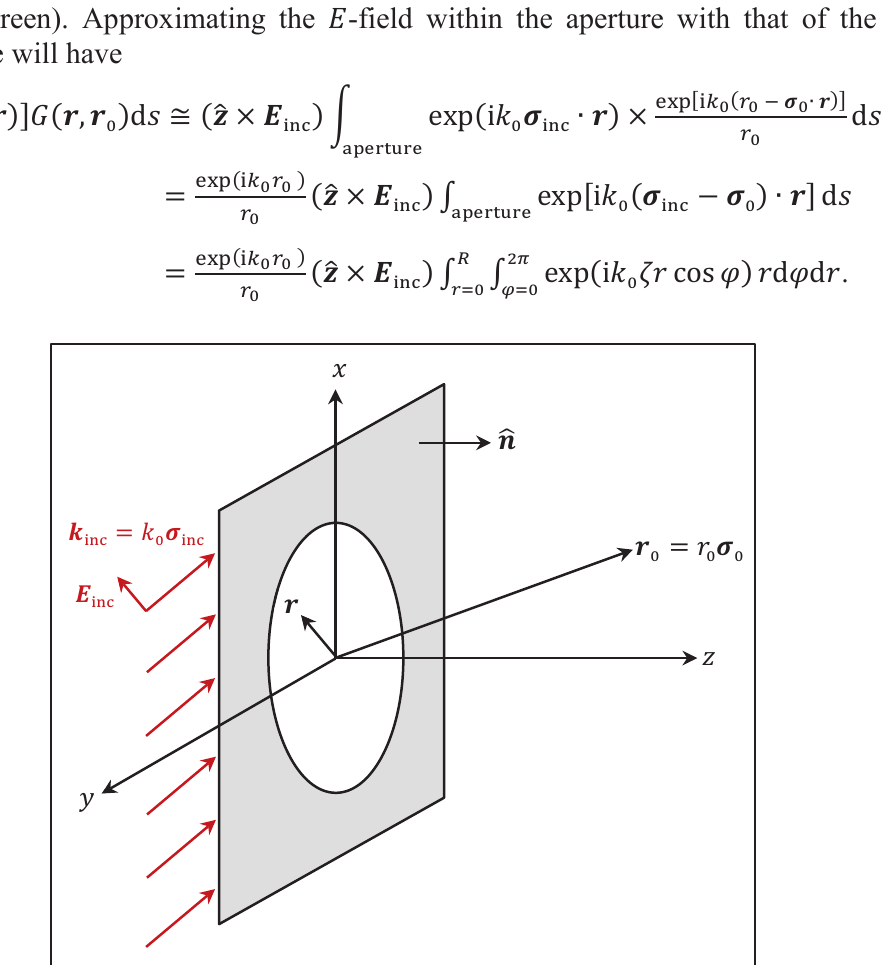
Fig.4 . A circular aperture of radius (cid:1844) inside an otherwise opaque screen located at (cid:1878) = 0 is illuminated by a plane-wave whose (cid:1831) -field amplitude and propagation direction are specified as (cid:2161) The observation point (cid:2200) respective polar coordinates ( (cid:2016) plane of the aperture is a vector of length (cid:2014) that makes an angle (cid:2030) with the position vector (cid:2200) = (cid:1876)(cid:2206)(cid:3549) + (cid:1877)(cid:2207)(cid:3549) . Here, (cid:2014) is the magnitude of the projection of (cid:2252)